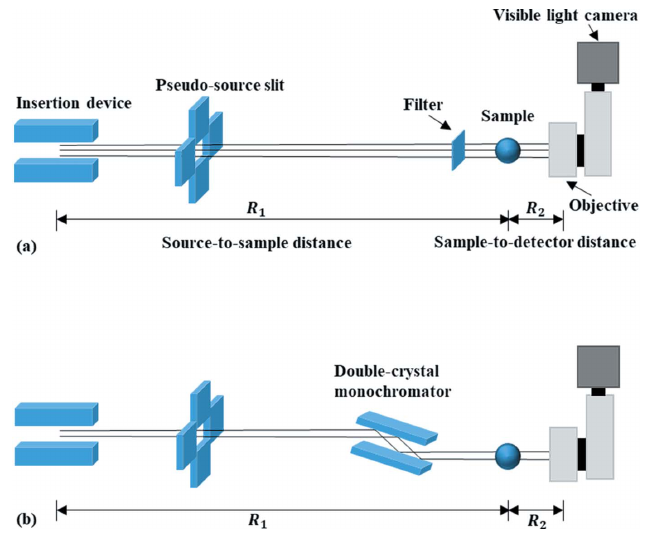
Figure 1 Schematic of the X-ray imaging experiment with synchrotron radiation ( a ) pink beam and ( b ) monochromatic beam.